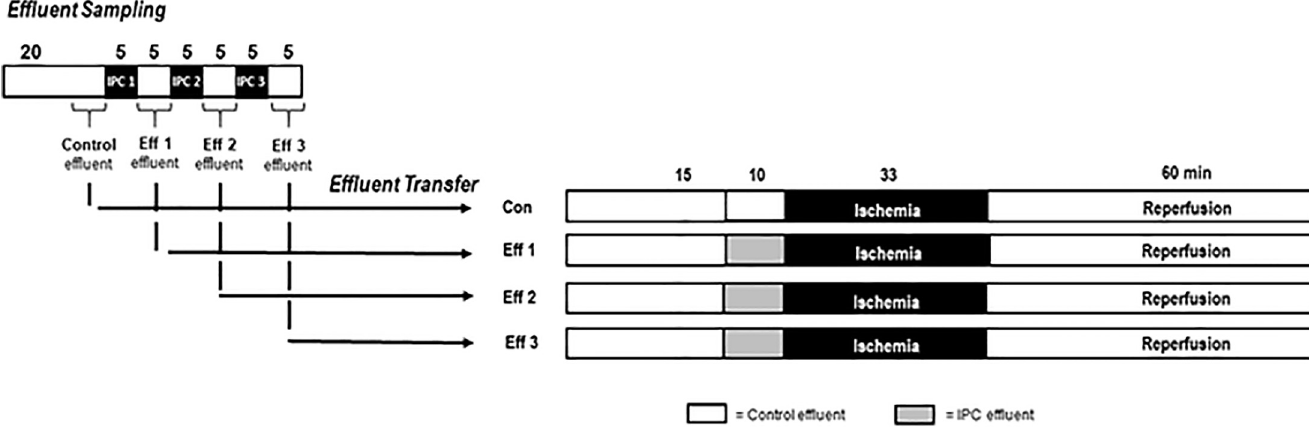
Fig 1. Effluent sampling and transfer protocol. Part 1: Effluent sampling. Coronary effluent was collected before (Con effluent) and during reperfusion after each 5-minute IPC cycle (Eff 1, Eff 2 and Eff 3). Part 2: Effluent transfer. Con = Control; Eff 1 = Effluent after one cycle of IPC; Eff 2 = Effluent after two cycles of IPC; Eff 3 = Effluent after three cycles of IPC; IPC = Ischemic preconditioning.